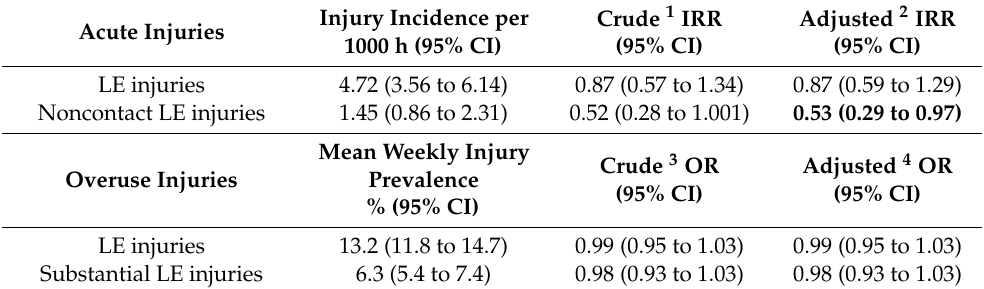
Table 4. Efficacy analysis of acute lower extremity (LE) injury incidence and overuse LE injury prevalence in ideal adherence intervention group compared to control